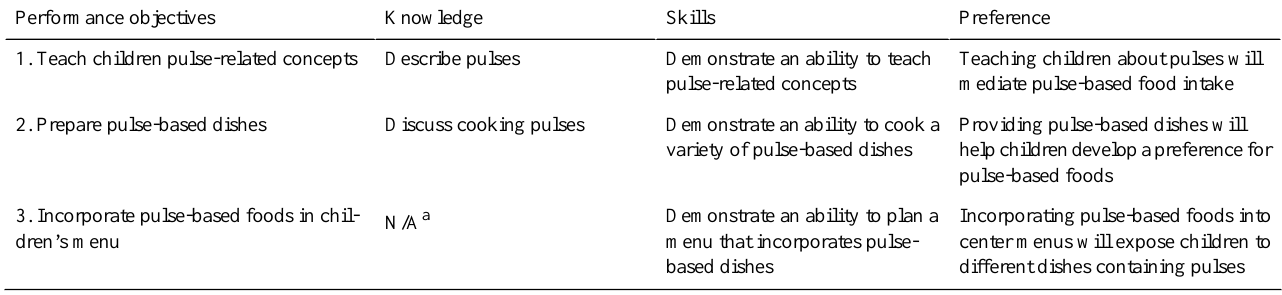
Table 2. Matrix of performance objectives for parents, early childhood educators, and cooks in the Pulse Discovery Toolkit